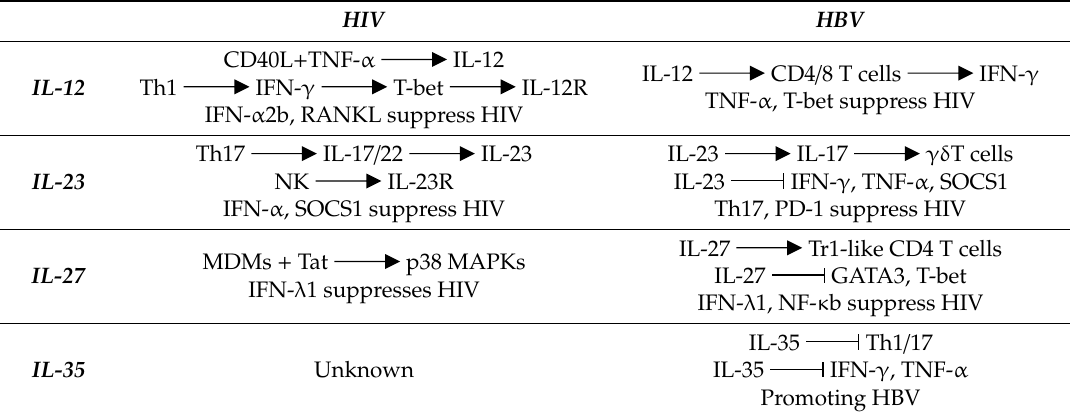
Table 1. Immune regulation by IL-12 family members during hepatitis B virus (HBV) and human immunodeficiency virus (HIV) infection.